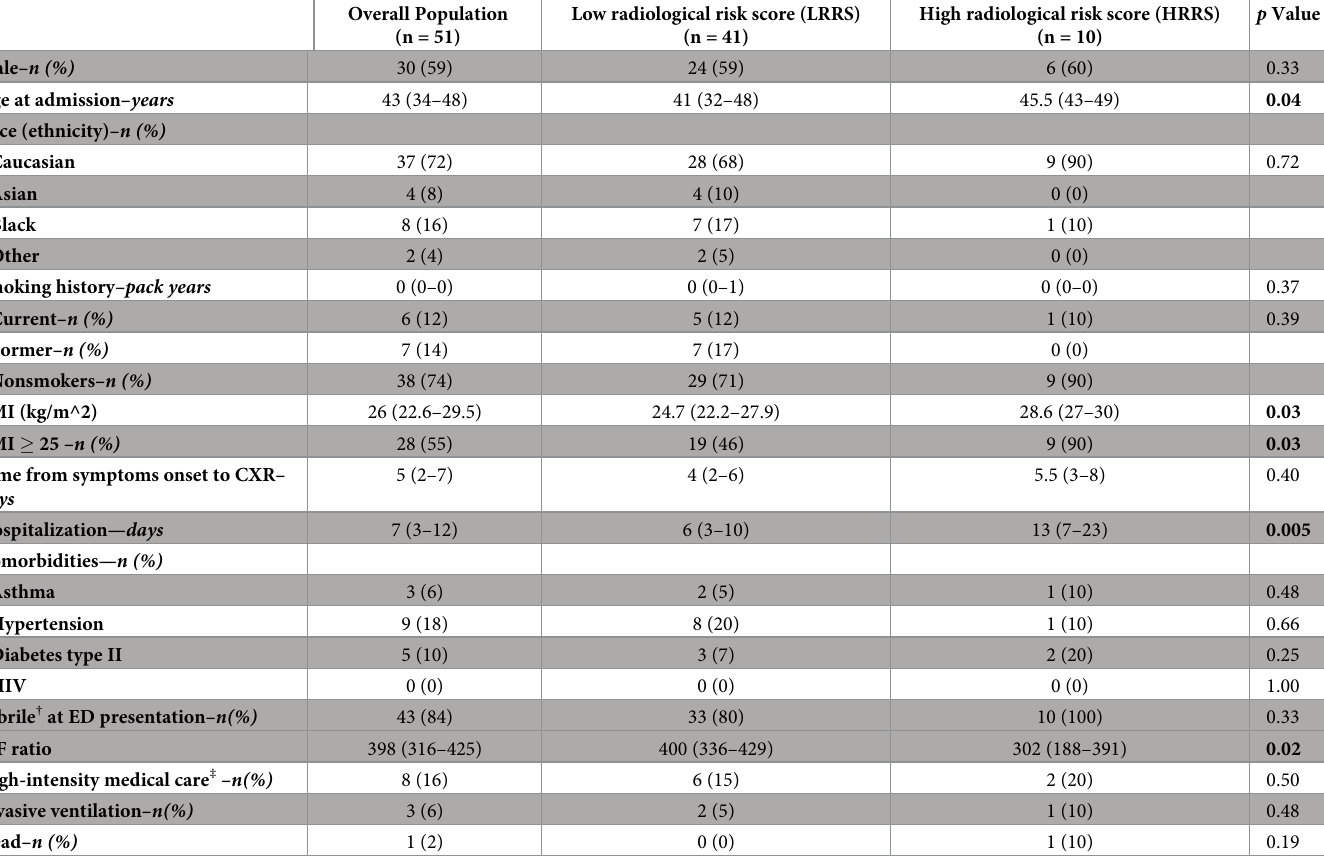
Table 1. Baseline demographics and clinical features of the overall young population hospitalized for SARS-CoV-2 related infection, and of the two subgroups cate- gorized in low (LRRS , 0–2) and high (HRRS , 3–6) radiological risk